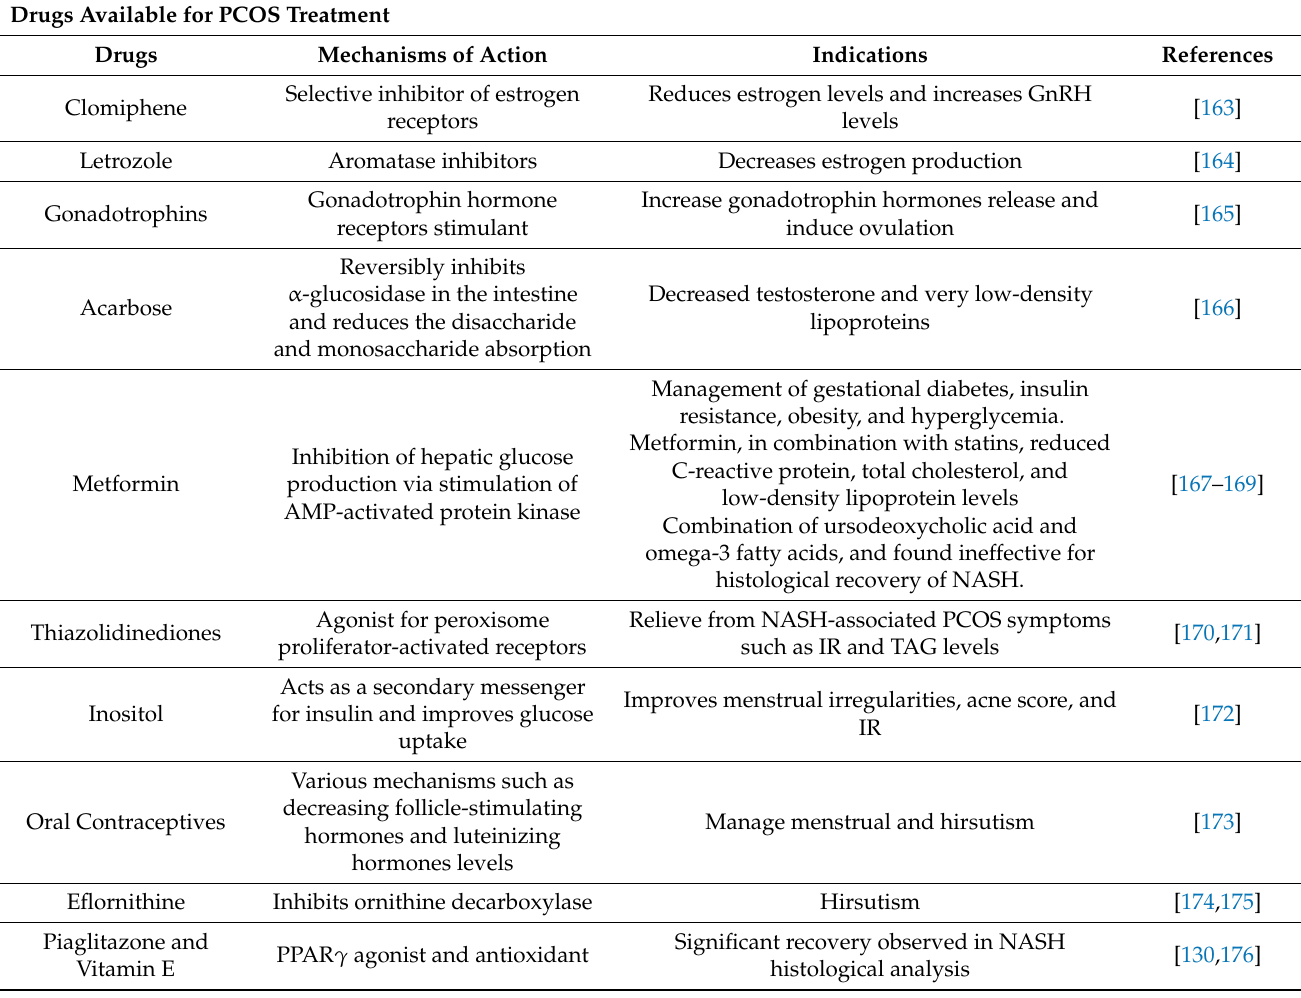
Table 1. Medications and drug candidates under development for PCOS